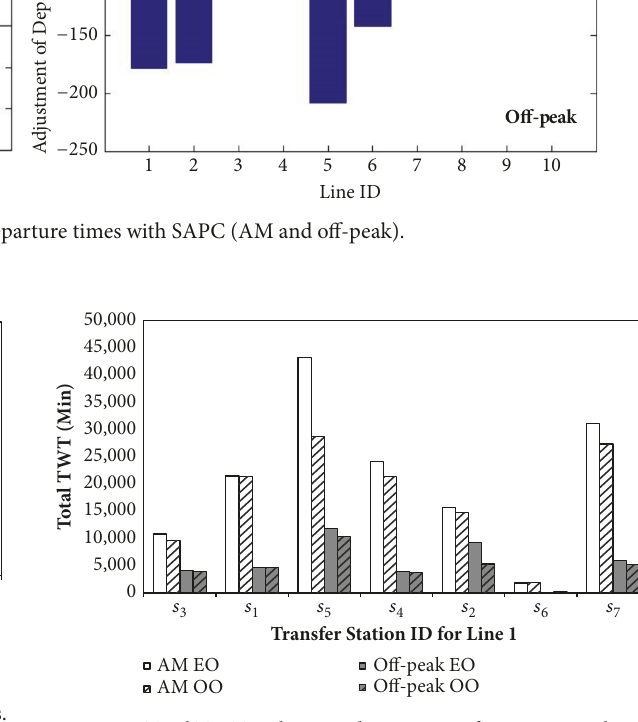
Figure 9: Total TWT with EO and OO at transfer stations on line